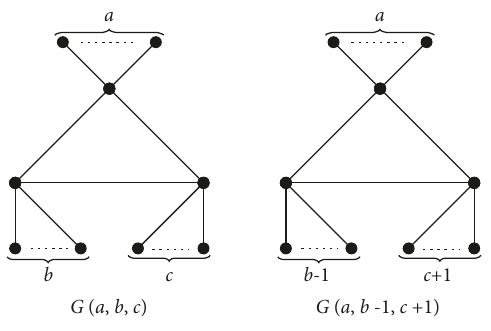
Figure 6: Graph in Theorem